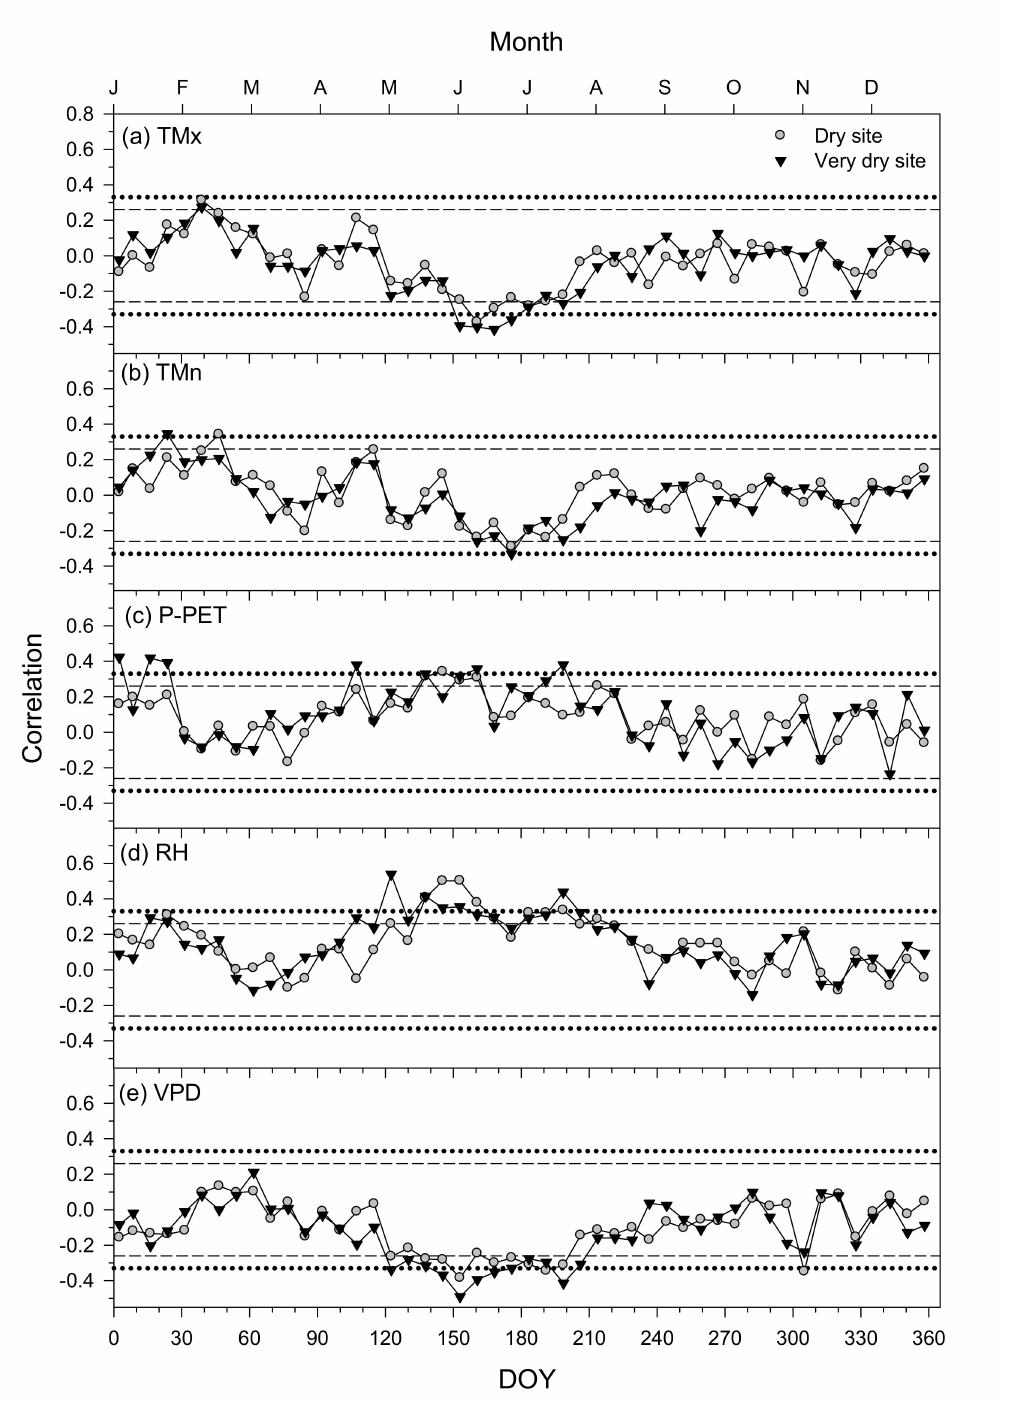
Figure 10. The climate–growth relationships of Juniperus phoenicea were assessed at a weekly resolu- tion at the dry and very dry sites. The analyzed climate variables were ( a ) TMx, ( b ), TMn, ( c ), P-PET, ( d ) RH, and ( e ) VPD. The horizontal dashed and dotted lines indicate the 0.05 and 0.01 significance levels,